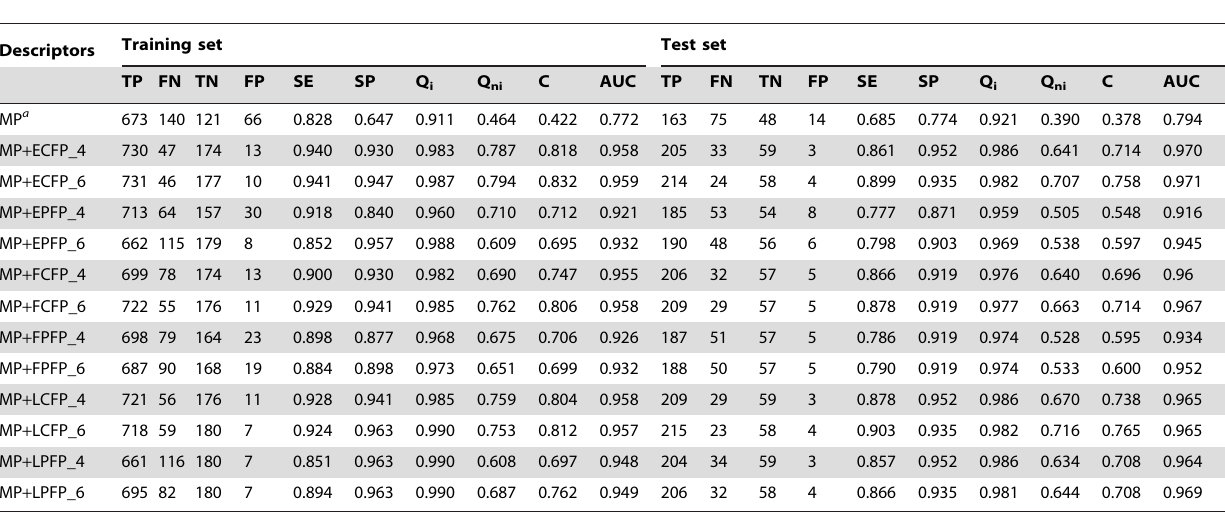
Table 2. Performance of the 13 Bayesian classification models for the training set and test set using different combinational of molecular properties and